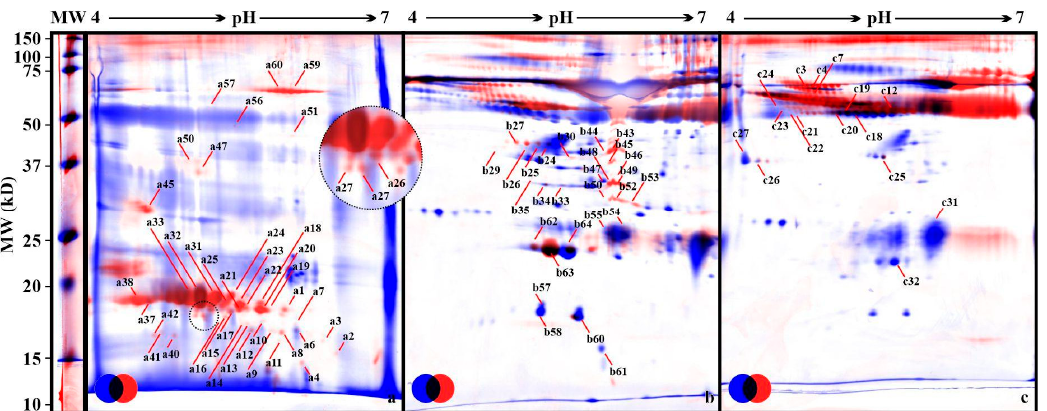
Figure 1. Fused gel images of the samples. Legend: ( a ) Saliva. ( b ) Plasma. ( c ) Albumin-free plasma, MW–broad range protein ladder. Arrows indicate identified proteins (see Tables S1–S3). Pool images from all samples in experiment n = 36. Control (C) group, blue; examined (P) group, red; common, black.